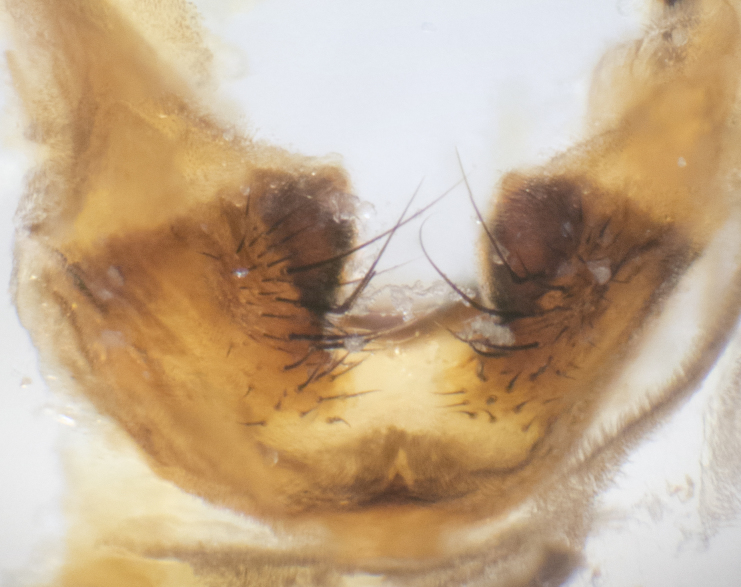
sternite 5, ventral view